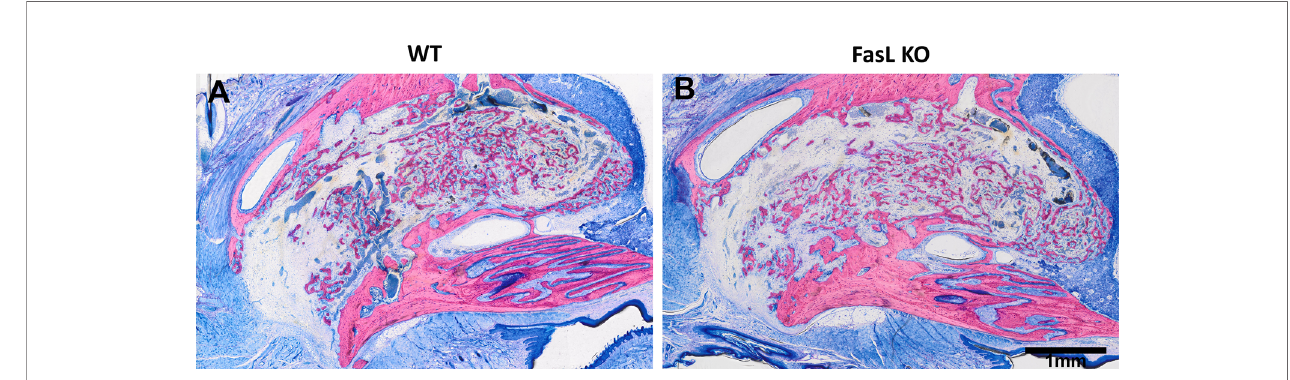
FIGURE 4 | The features of the newly formed bone were similar for the WT (A) and the FasL KO mice (B) . Overview photomicrographs (2x) depicting the